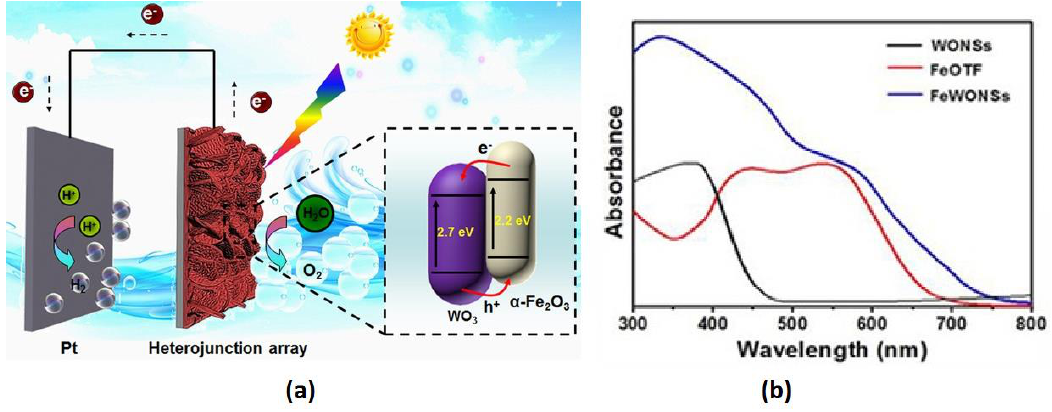
Figure 12. Figure 12. ( a ) WO